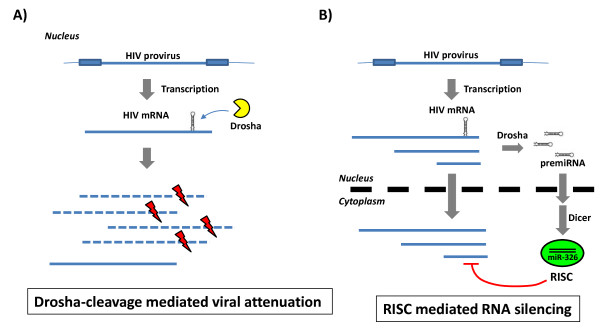
Two mechanisms by which expressed intragenomic miRNAs can affect viral replication. (A) An integrated HIV-1 genome is transcribed into viral mRNAs containing the embedded primary miRNA. This viral mRNA with an embedded primary miRNA may be recognized and cleaved in the nucleus by Drosha (in yellow). If Drosha-mediated cleavage is overly efficient, few uncleaved viral RNA would be left available to export into the cytoplasm for translation and/or packaging. This would then result in attenuated or incompetent viral replication like the NL4-3 miR211 virus. (B) For most chimeric NL4-3 miRNA viruses, Drosha processing of the embedded primary miRNA is relatively inefficient. Thus two pools of RNAs (unprocessed viral RNA and processed pre-miRNAs) are exported from the nucleus into the cytoplasm. In the case of the NL4-3 miR326 virus, the primary miR326 is further processed by Dicer into mature miR326 which associates with RISC and silences complementary viral target sequence leading to the attenuation of viral replication.